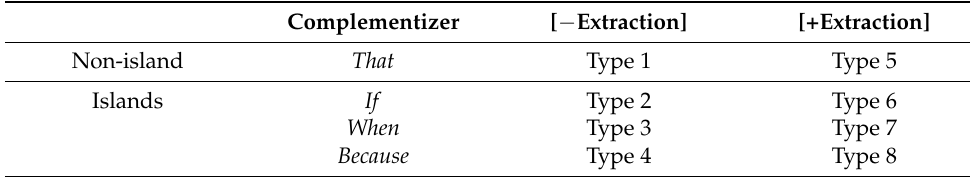
Table 1. Experimental